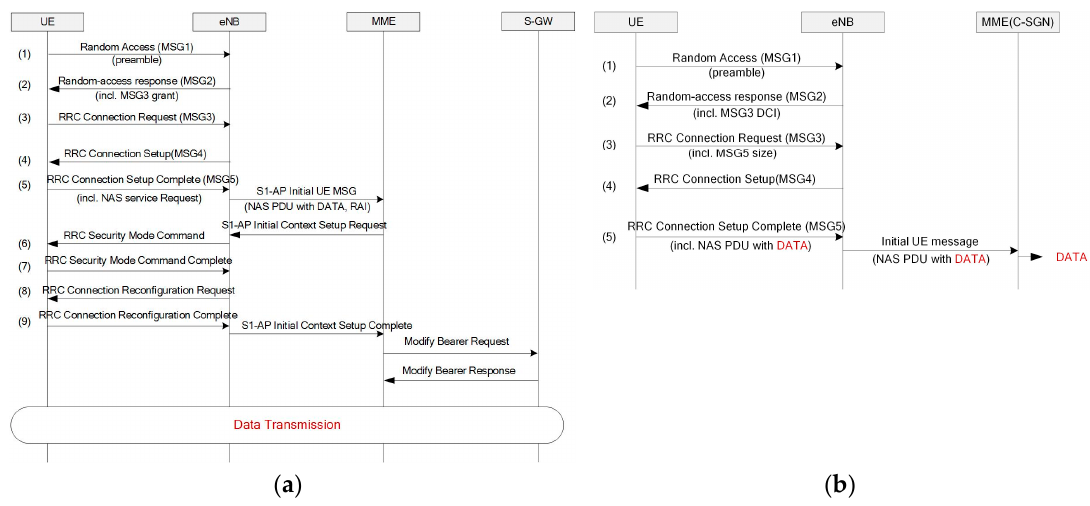
Figure 7. Packet transmission scheme: ( a ) existing long-term evolution (LTE); ( b ) NB-IoT with control-plane (CP) cellular IoT (CIoT) optimization.